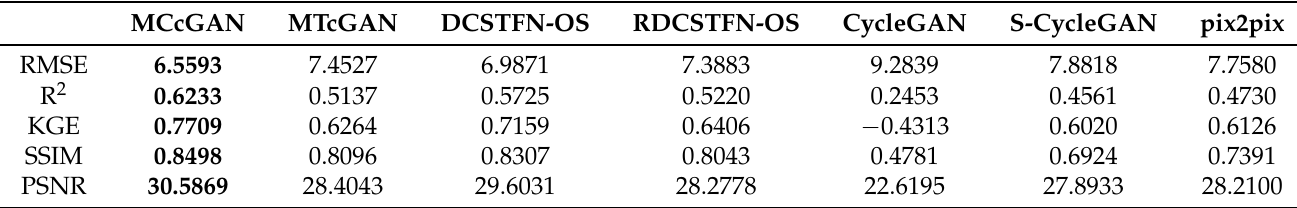
Table A2. The evaluation metrics of different methods for the green band in Area B at Time III (the bold result is the best among the different